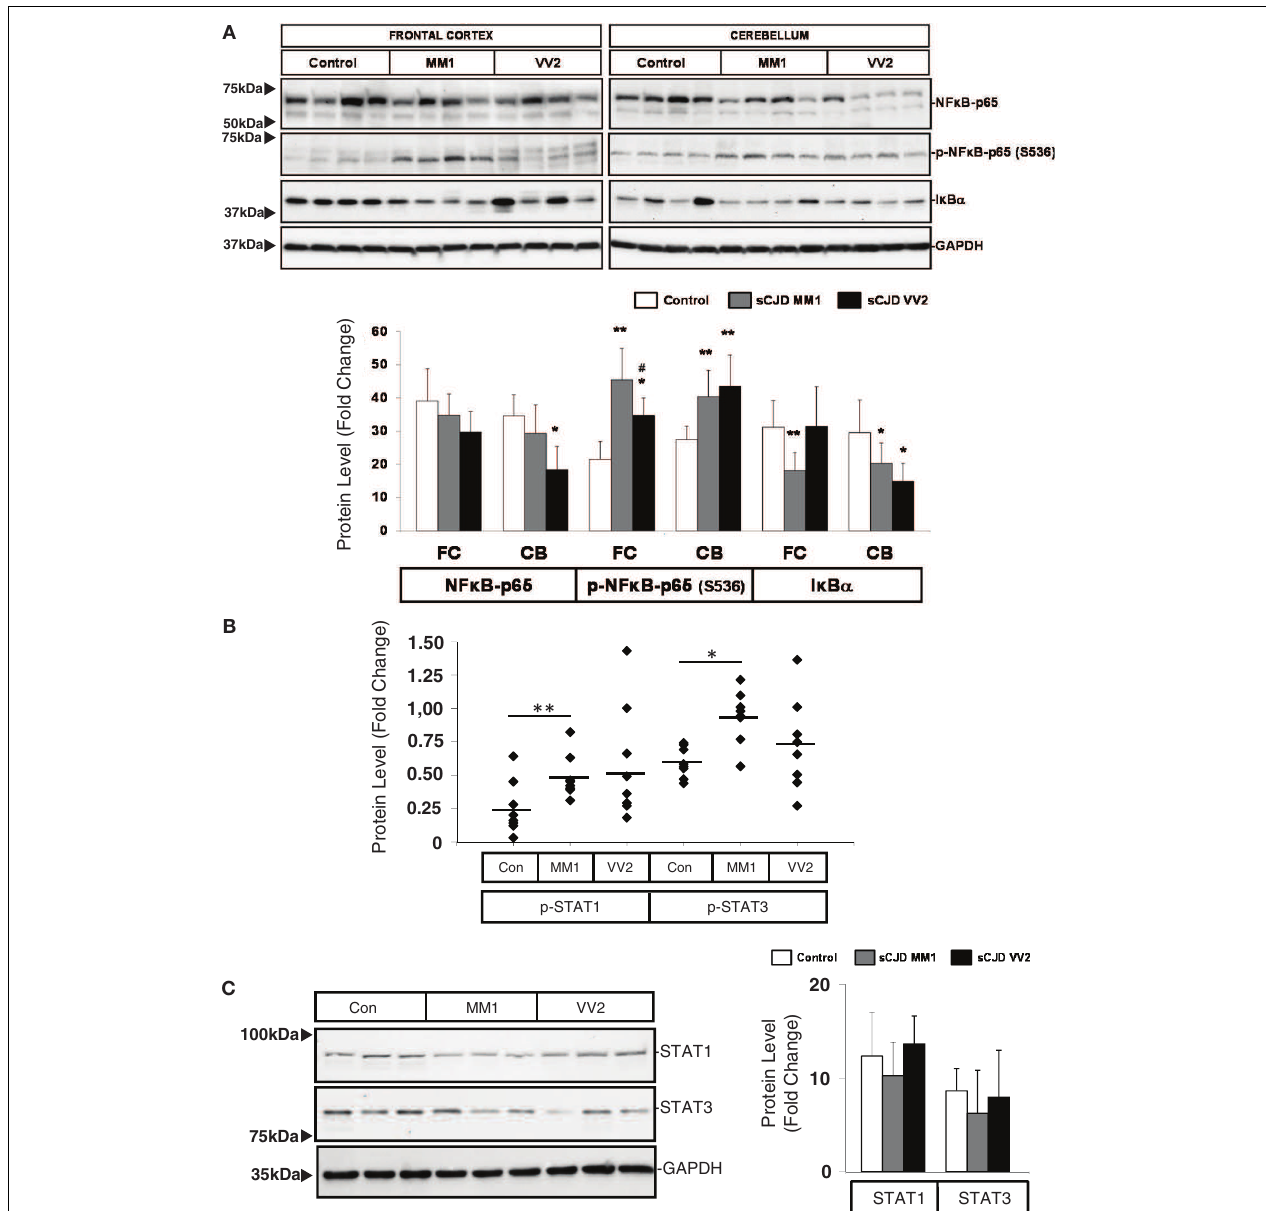
# p > 0.05 sCJD MM1 versusVV2. AU: arbitrary units. (B) ELISA of p-STAT1 and p-STAT3 in the frontal cortex of control (Con), sCJD MM1 (MM1), and sCJDVV2 (VV2) cases.Total values result from the analysis of eight controls, eight MM1, and eightVV2 cases. (C) Western blotting of STAT1 and STAT3 in the frontal cortex of control (Con), sCJD MM1, and sCJD VV2 cases.Three representative cases of a total of 15 cases analyzed are shown. GAPDH immunostaining was used to normalize total protein loading. * p > 0.05, ** p > 0.005 control versus sCJD; # p > 0.05 sCJD MM1 versus sCJDVV2. AU: arbitrary